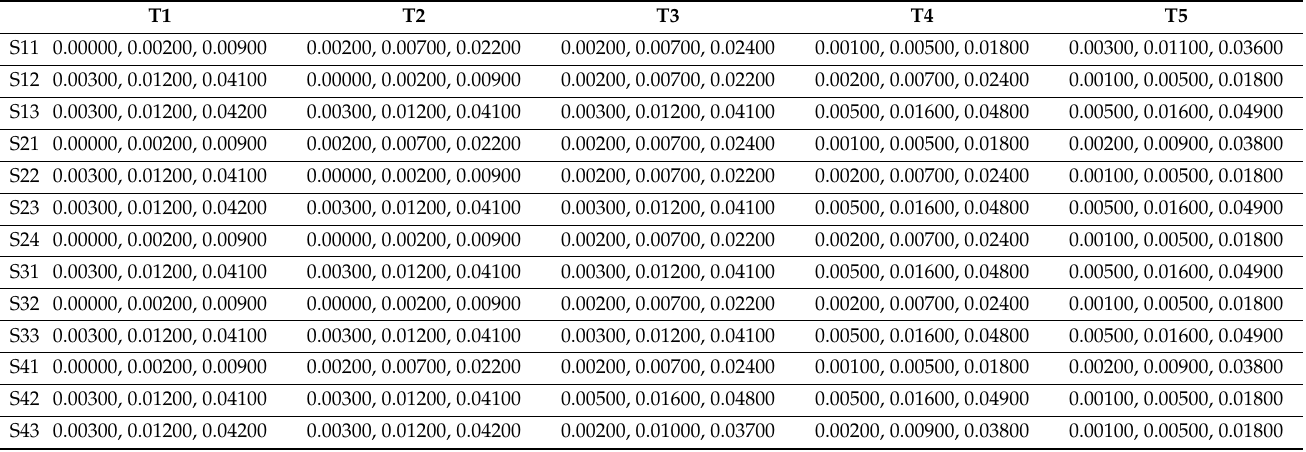
Table 14. The weighted normalized fuzzy-decision matrix.